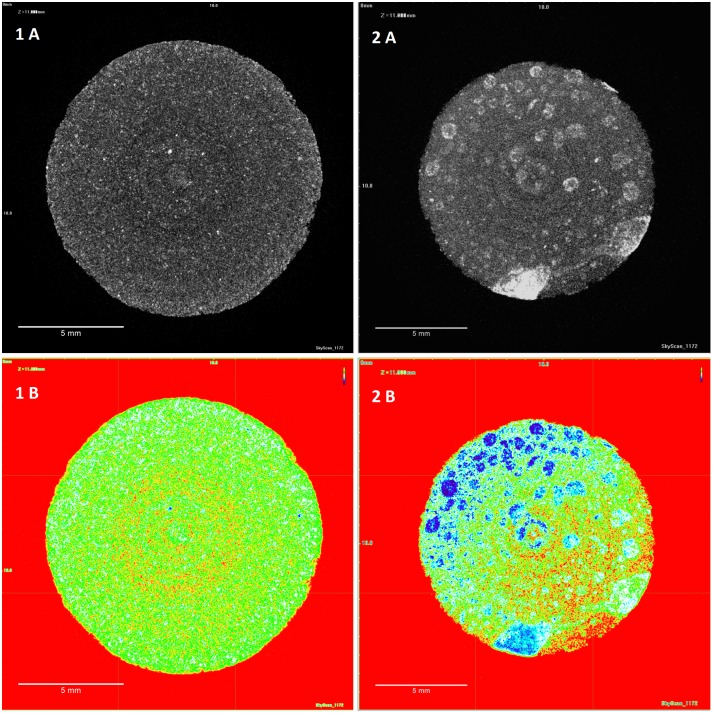
Maximum projection and heat map images of the tablet surface of XμCT reconstructed film coated tablets of either large or small droplet size.Placebo tablets were coated with Kollicoat IR and bismuth oxide (2.5% w/w). Droplet size coatings of 20μm (1) and 70 μm (2) are shown in maximum projections (A) and heat maps (B). Heat maps demonstrate coat uniformity, with blue areas and red areas representing high and low intensity of radiopacity, respectively.